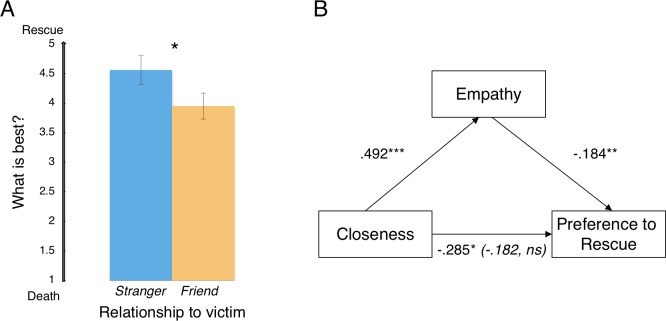
Results of Experiment 1.Panel A. Participants who considered a stranger in a painful, life-threatening situation expressed greater preference to save the person’s life than those who considered a friend in the same situation. Panel B. The relationship between closeness and the preference (not) to rescue was mediated by empathy, with higher empathy leading to lower rescuing preference. Standardized regression coefficients are indicated. Parentheses designate the standardized regression coefficient for the relationship between closeness and decision when controlling for empathic emotion; the relationship is no longer significant (p>.2). Condition was dummy-coded: stranger = 0, friend = 1. Error bars represent SEM. *p < .05; **p < .01. *** p < .001.